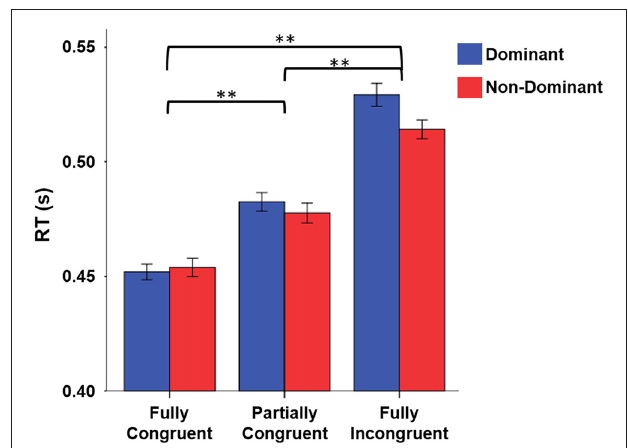
FIGURE 2 | Reaction time (RT) differences by Condition by Side. RT was significantly higher for Fully Incongruent than Partially Congruent than Fully Congruent. No differences were found between Dominant and Non-Dominant side. ∗∗ p <